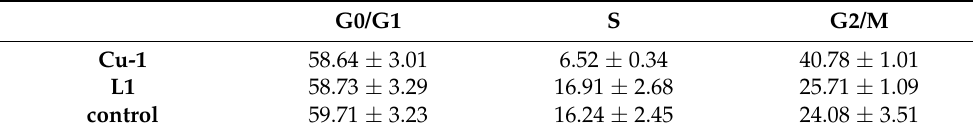
Figure 10. DCF fluorescence intensity of cells after treatment with Cu-1 , the corresponding L1 and Cu(NO 3 ) 2 · 3H 2 O as a measure of the reactive oxygen species produced. Values represent the mean ± SD of three independent experiments and the significance level was set as ** p < 0.01 and *** p < 0.001 compared to control (untreated cells). Table 4. Cell cycle phase distribution after exposure of MCF-7 for 72 h with Cu-1 and L1 (%)